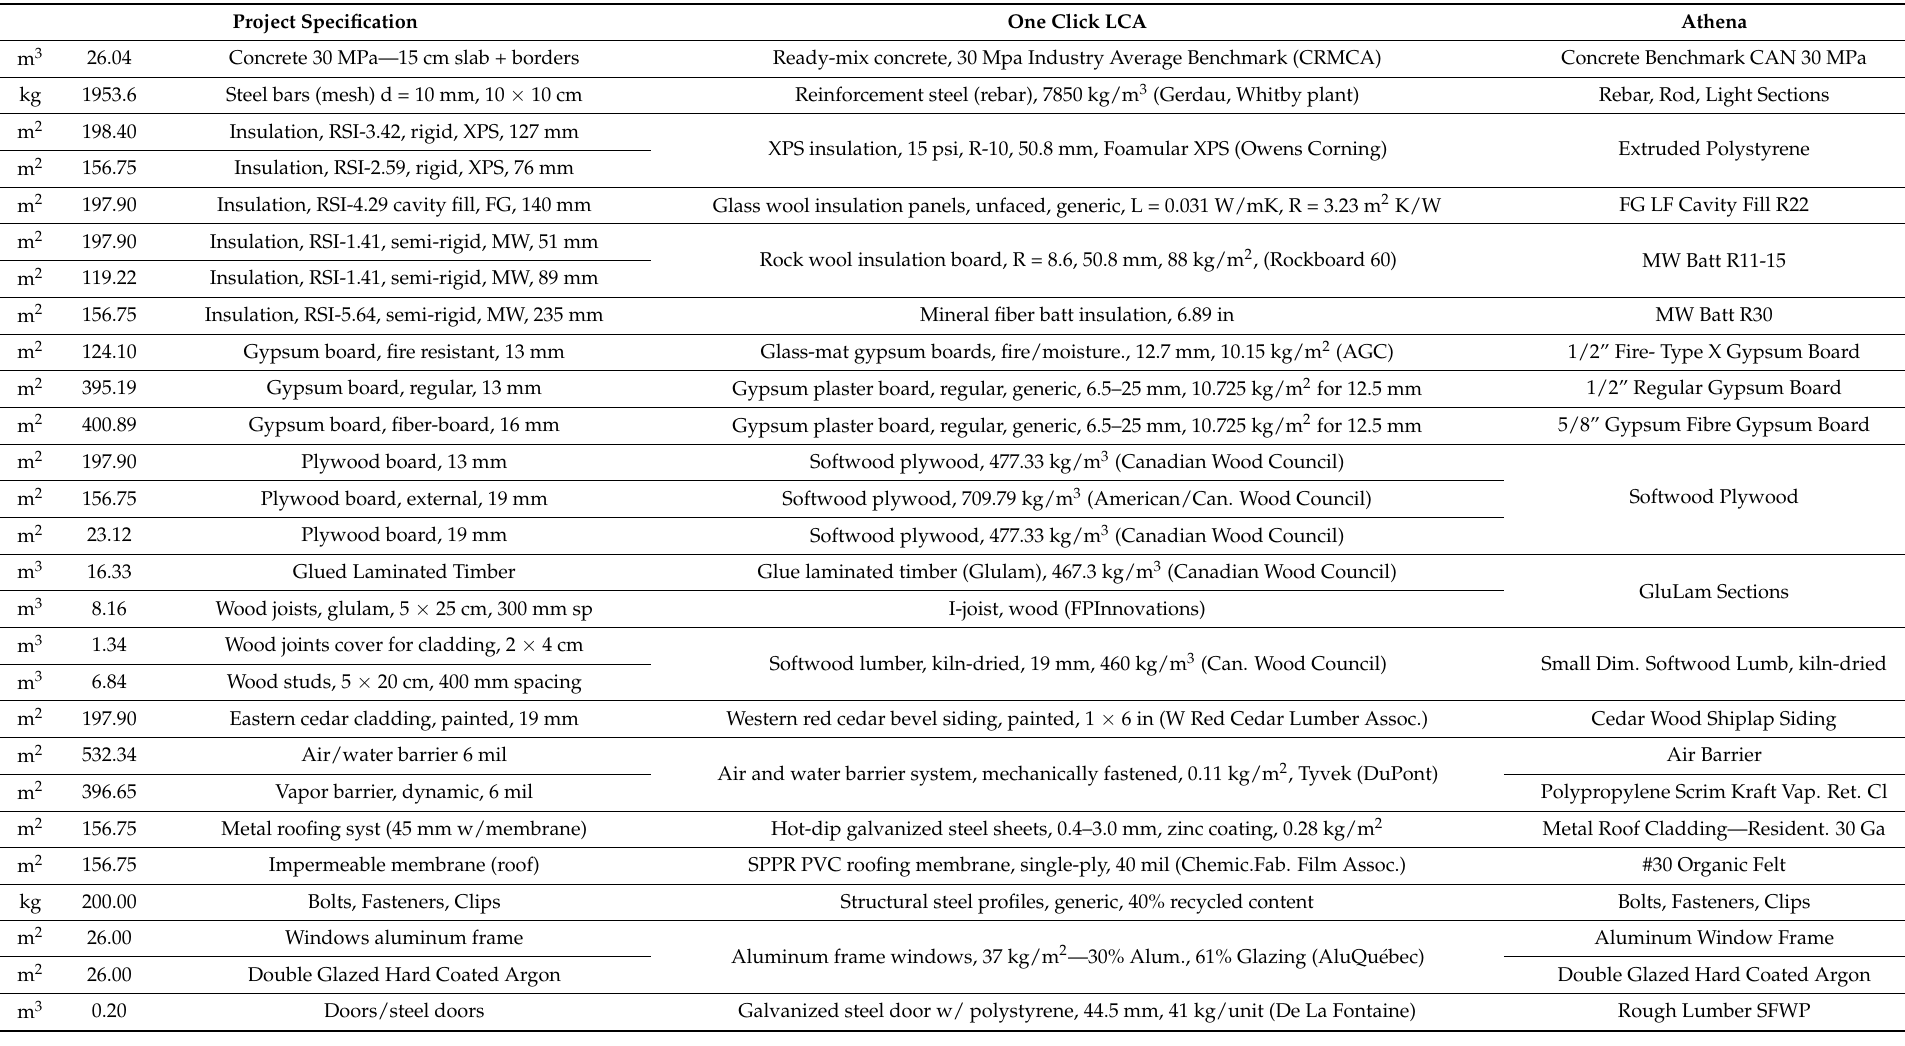
Table 4. Bill of materials according to Future Buildings Lab’s design specs, and correspondent material option chosen in One Click LCA and